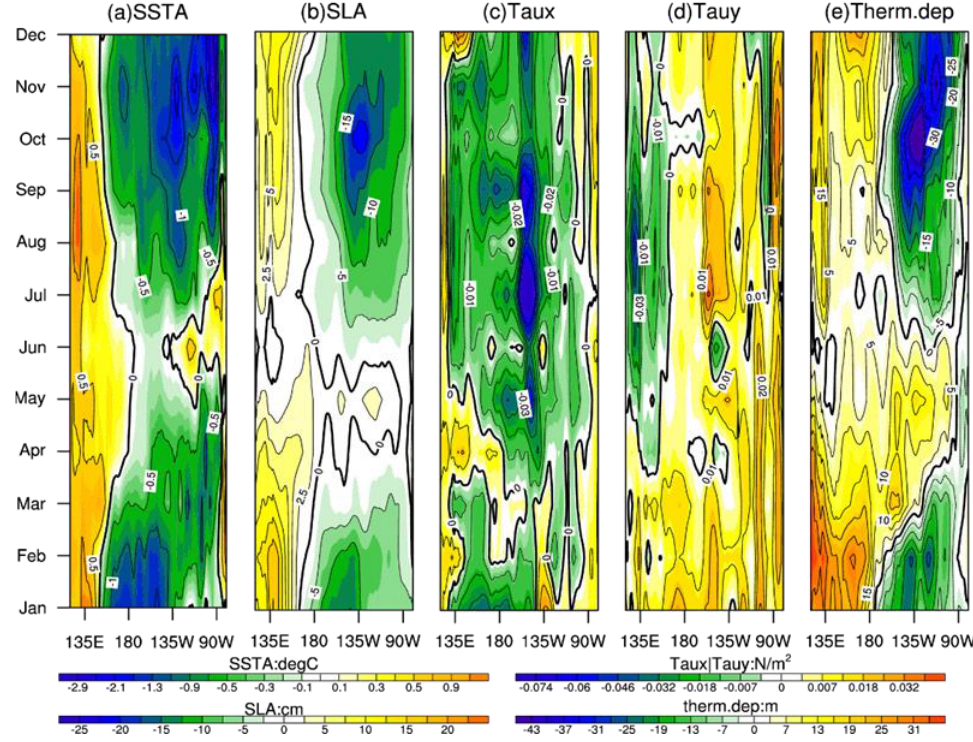
Figure 2. Zonal- time sections along the equatorial Pacific (averaged at 2° S−2° N) for